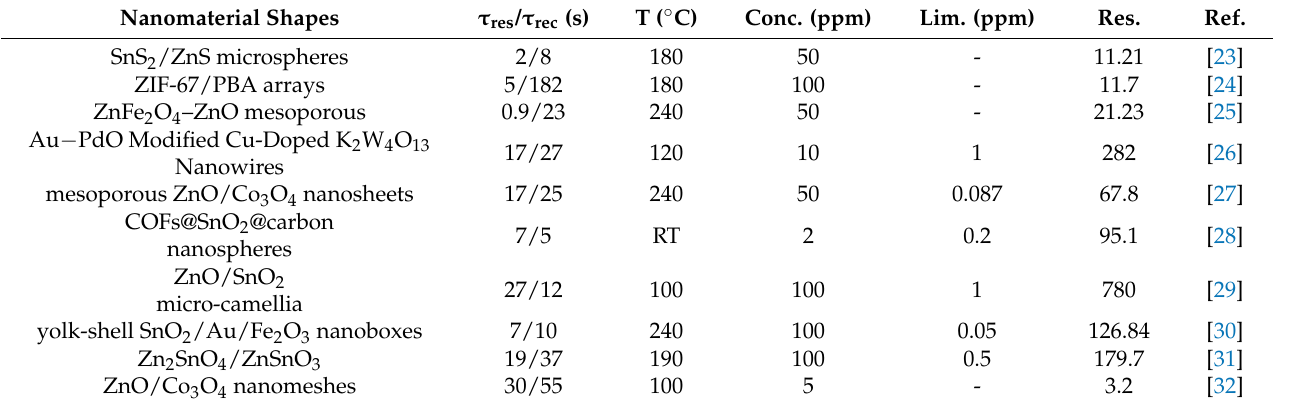
Table 1. The sensing characteristics of several typical triethylamine